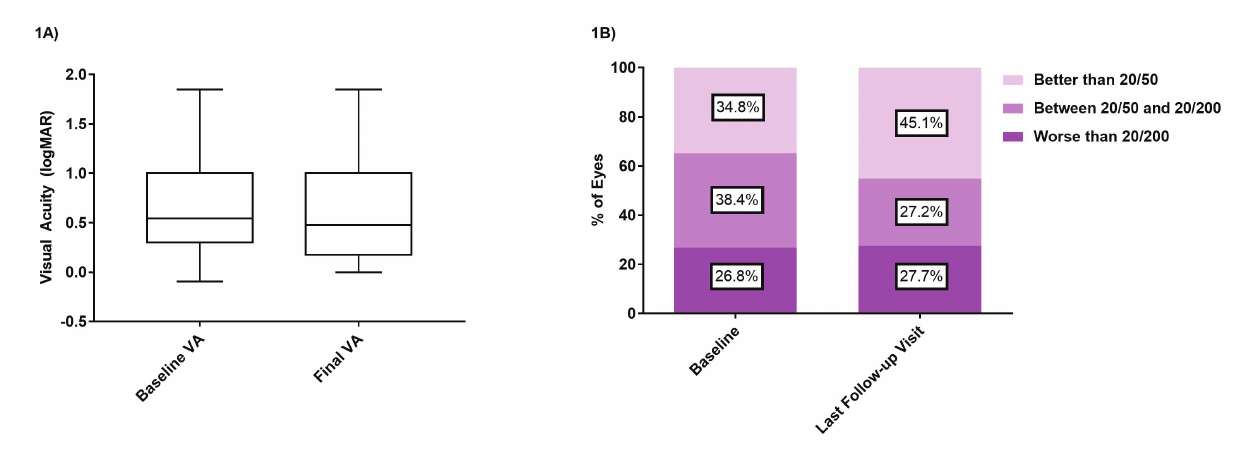
Figure 1. Comparison of mean visual acuity between baseline and last visit. Figure 1A shows boxplot comparisons between baseline and final visual acuities. Figure 1B shows the percentage of patients in each visual acuity category by the last follow-up visit compared to